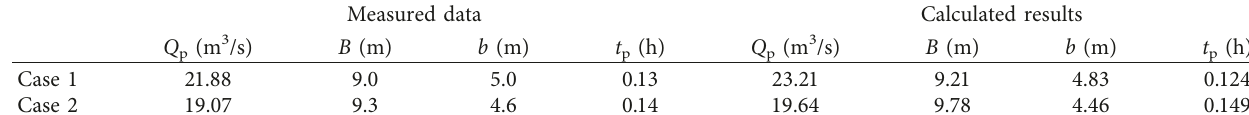
Table 3: Comparison between the calculated results and the measured results.